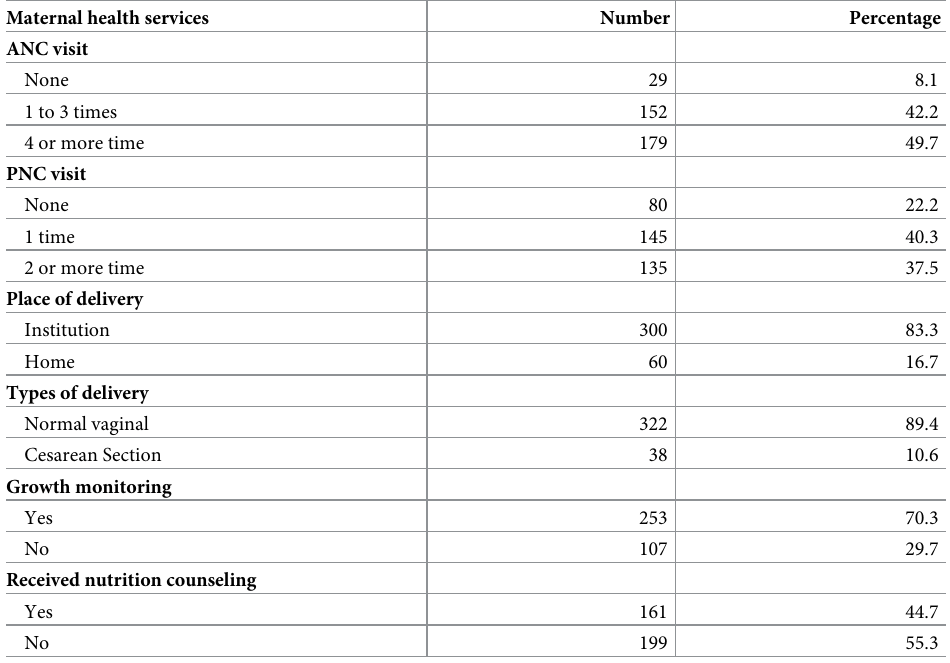
Table 2. Distribution of participants by utilization of maternal health